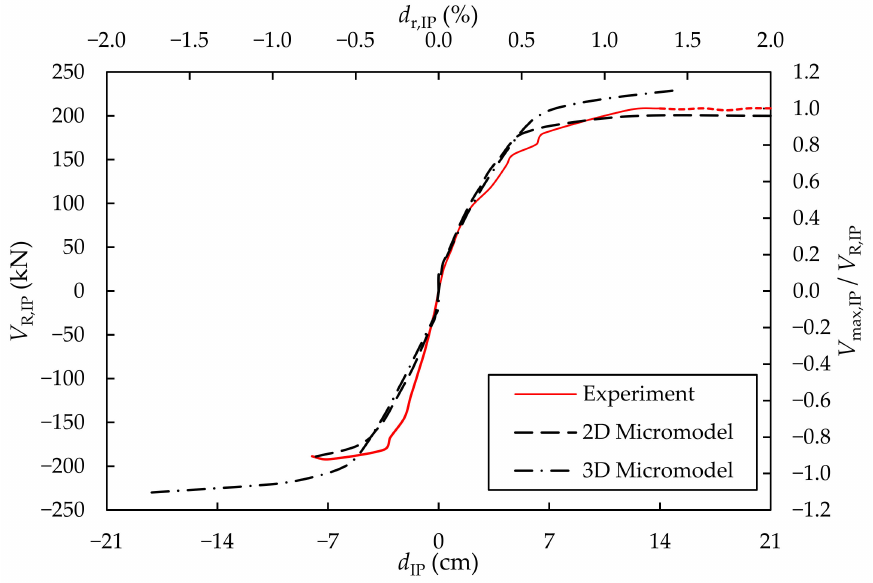
Figure 19. 2D vs. 3D micromodel approach on BF